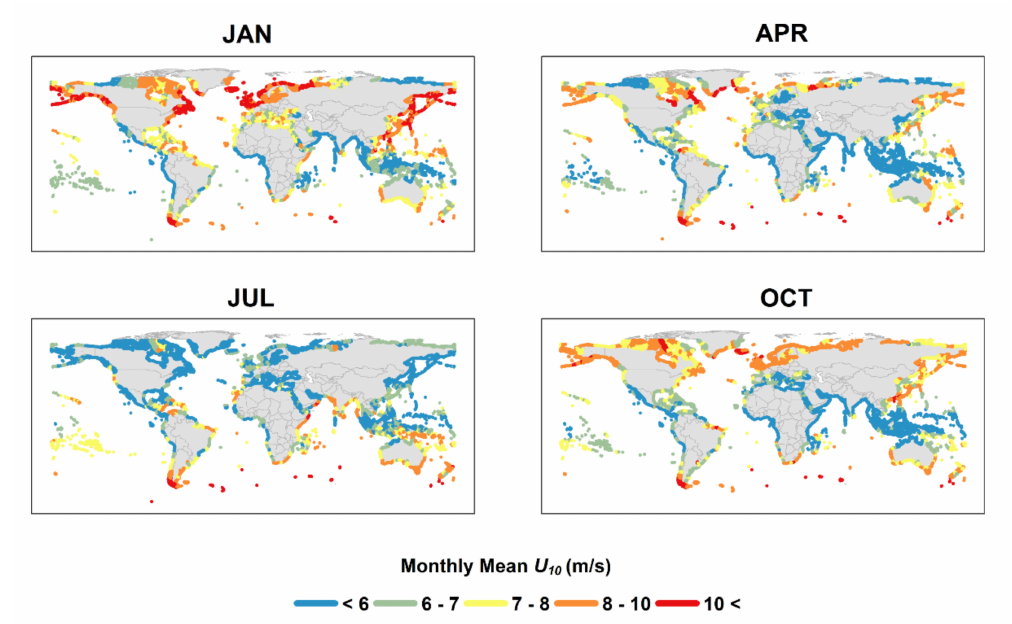
Figure 5. Mean monthly wind speed, at a reference elevation of 10 m ( U 10 ), U 10 at near-coastal locations defined by the DIVA